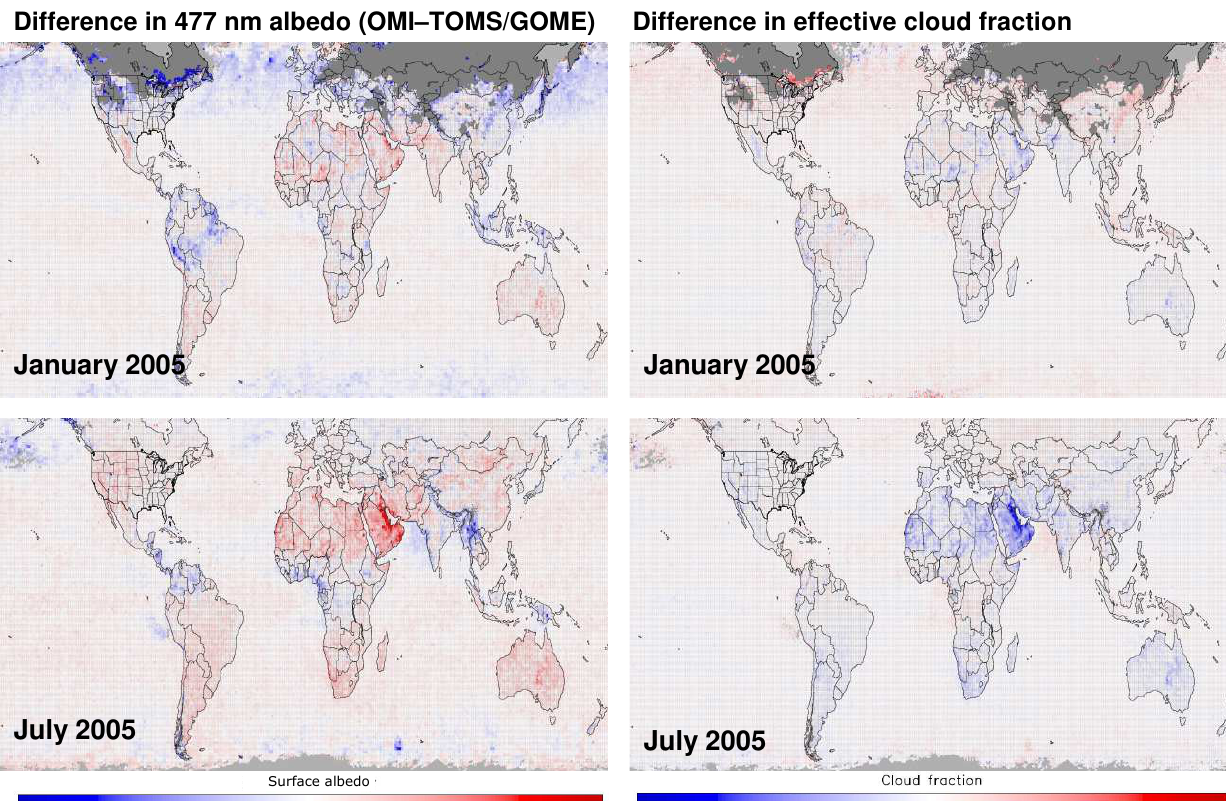
Fig. 3. Left column: difference in surface albedo between OMI (477nm) and TOMS-GOME (479.5nm) for monthly mean climatologies for January and July 2005. Right column: (OMI–v1.02) difference in retrieved effective cloud fractions from the O 2 -O 2 algorithm calculated with different surface albedo climatologies (v1.02: TOMS-GOME, improved algorithm: Kleipool et al., 2008). Scenes with snow or ice have been excluded.